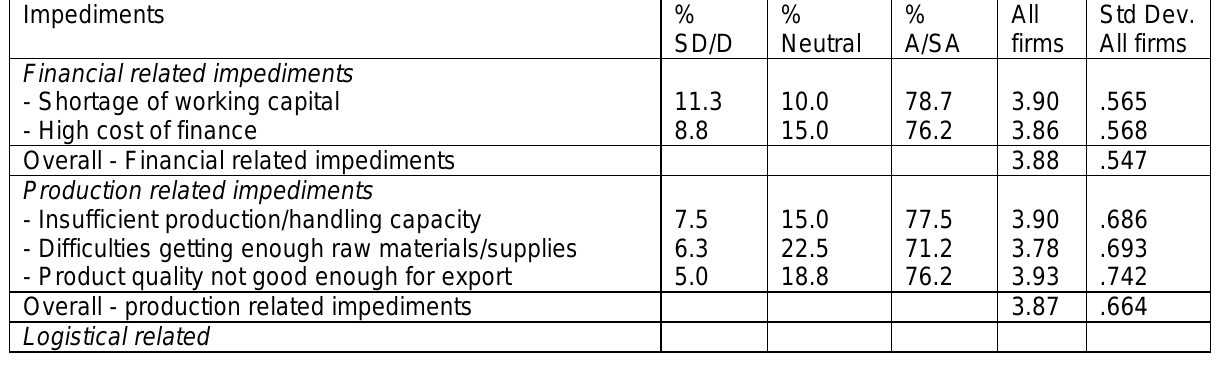
Table 2: Impediments to export involvement Impediments %